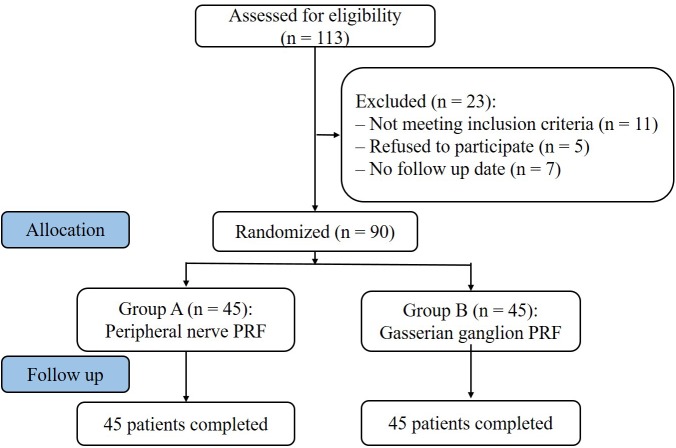
Study flowchart. All 90 patients were included in the treatment. PRF, pulsed radiofrequency.